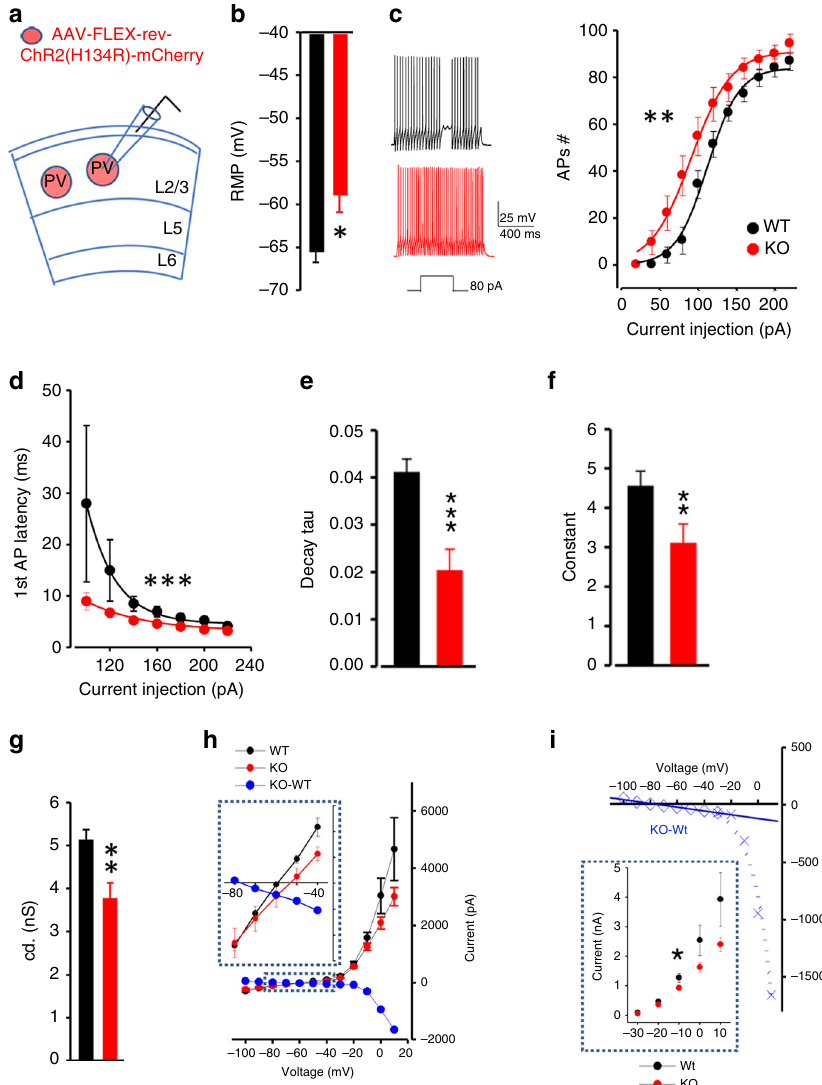
Fig. 2 Increased excitability of PV neurons in PV- Lmo4 KO mice. a Diagram of AAV9 vectors expressing cre-dependent mCherry stereotactically injected to the dACC of WT (PV-Cre/ Lmo4 WT/WT ) or KO (PV-Cre/ Lmo4 fl ox/ fl ox ) mice to label PV neurons. Altered PV neuron properties include: b depolarized resting membrane potential, c increased membrane excitability (current injection – action potential curve, fi tted to a sigmoidal function, shows a leftward shift with reduced threshold and increased number of action potentials). Representative traces are shown. d – f Latency to fi rst action potential was reduced ~1.45 ms, n = 5 WT, 5 KO mice. Current injection – 1st AP latency, fi tted to a three-parameter exponential decay, revealed a smaller decay tau ( e ), and a shorter time constant ( f ). g Reduced resting membrane conductance. h , i I-V curves: the net difference between WT (black) and KO (red) I-V curves is shown in blue. Boxed insets show further expanded current scales to reveal differences. Note ( i ) a linear fi t between − 100 and − 40 mV and an exponential fi t above − 40 mV revealed reduced voltage-independent (leak) and voltage-dependent delayed rectifying conductances in KO; inset: isolated delayed recti fi ed potassium currents. (Note: all values not adjusted for junction potential of 15 mV). All data are presented as means ± SEM. *, **, ***, p < 0.05, 0.01, 0.001, respectively. N = 9 – 11 cells from 5 WT and 8 – 13 cells from 5 KO